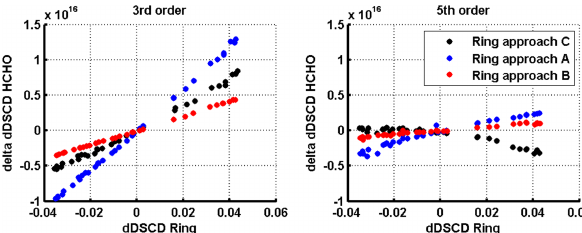
Fig. 11. Sensitivity of HCHO dDSCD (moleccm − 2 ) to changes in the Ring cross section used in the DOAS fitting procedure, ex- pressed as the difference to the baseline scenario, for data recorded on 4 July 2009. The two panels present the results for different or- ders of the polynomial used in the DOAS